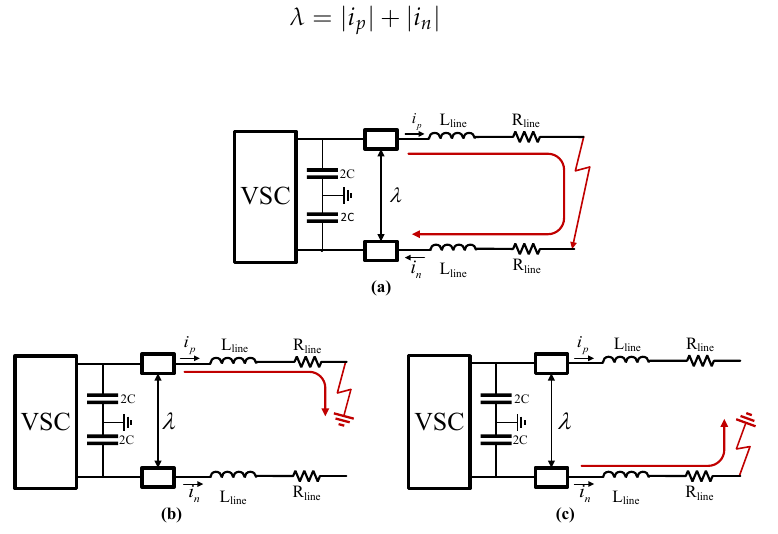
Figure 4. Fault current paths during: ( a ) pole-to-pole fault; ( b ) positive pole-to-ground fault; ( c ) negative pole-to-ground